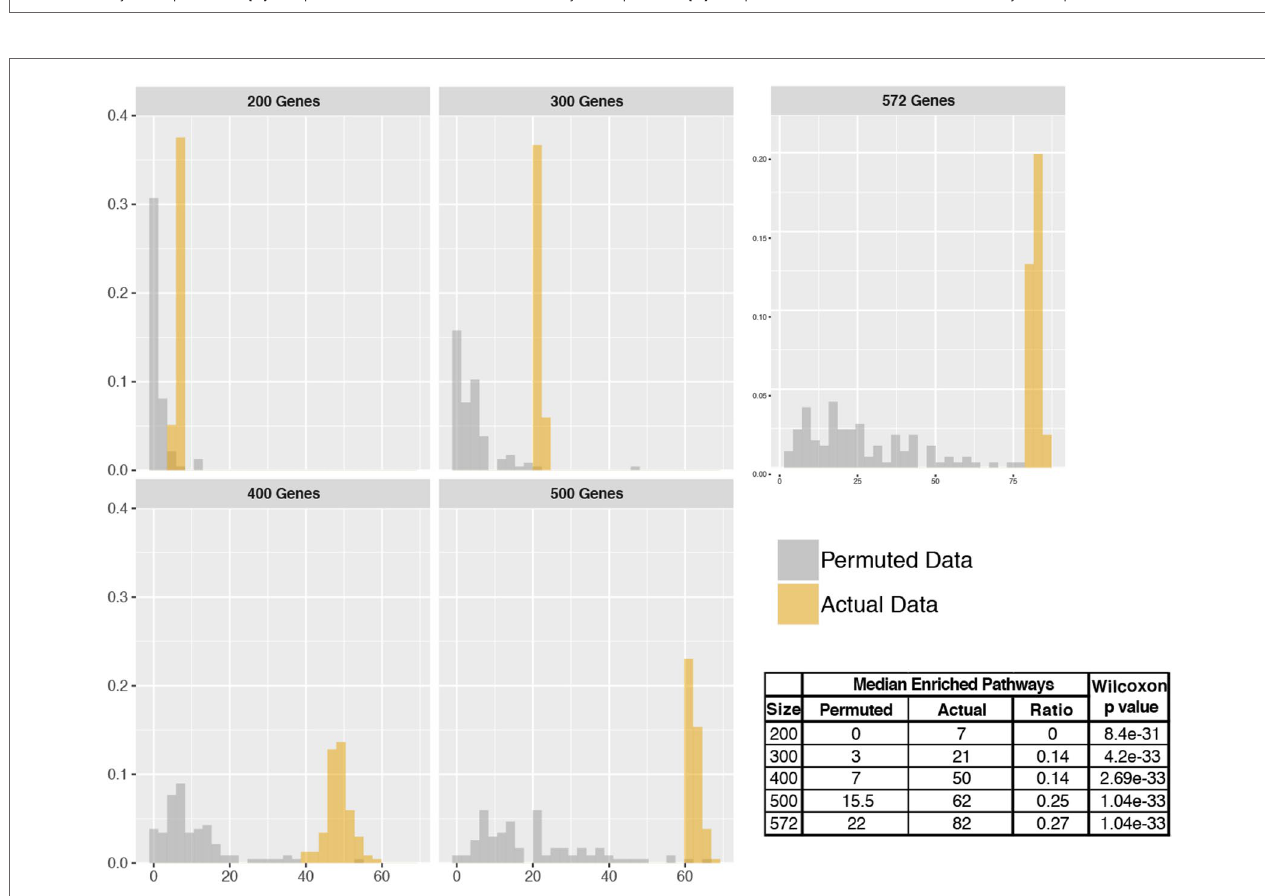
FIGURE 6 | Distributions of the number of enriched pathways for actual vs. permuted data. Histograms displaying the distributions of the number of enriched pathways for actual and permuted data for input sizes of 200, 300, 400, 500, and 572. The x axes correspond to the number of enriched pathways, and the y axes correspond to relative frequencies. On the right bottom, a table summarizing the results is